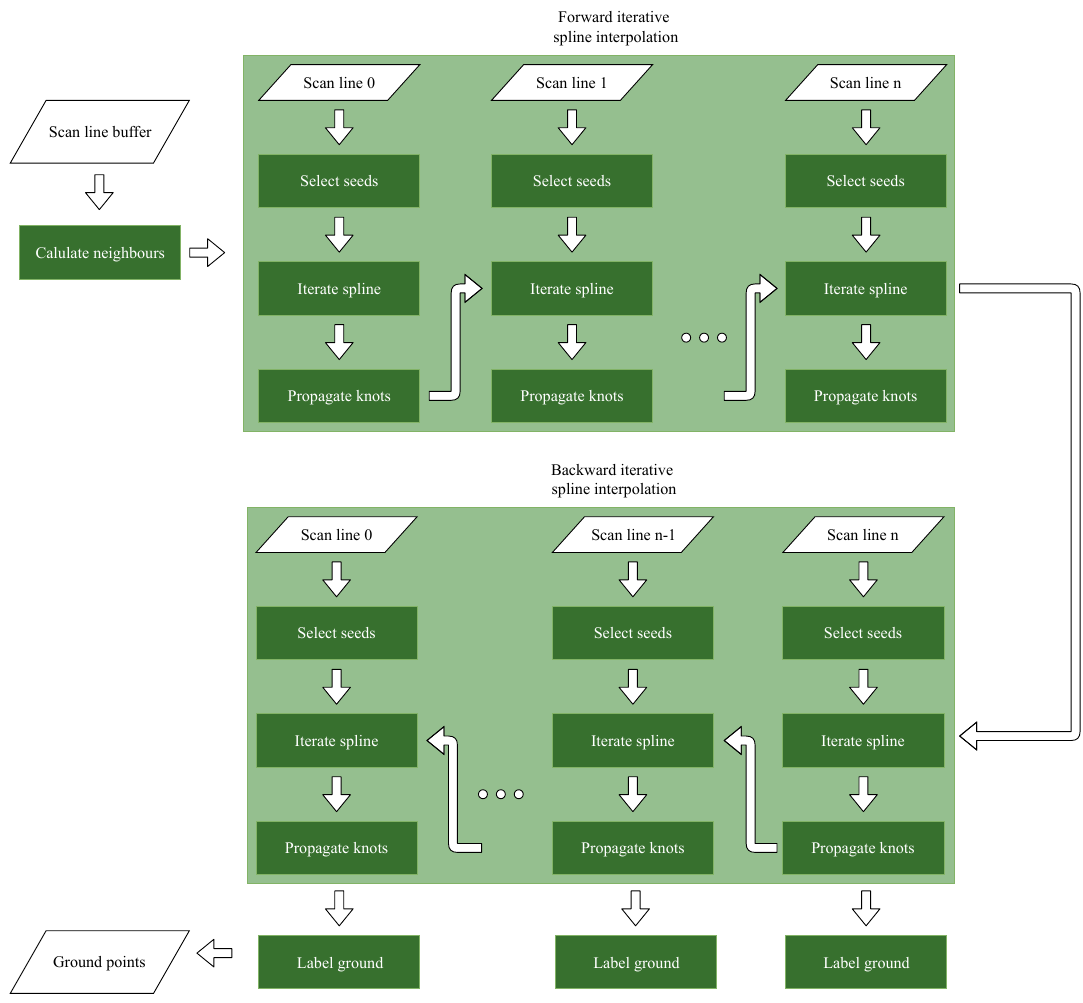
Figure 3. Flowchart of the iterative spline ground